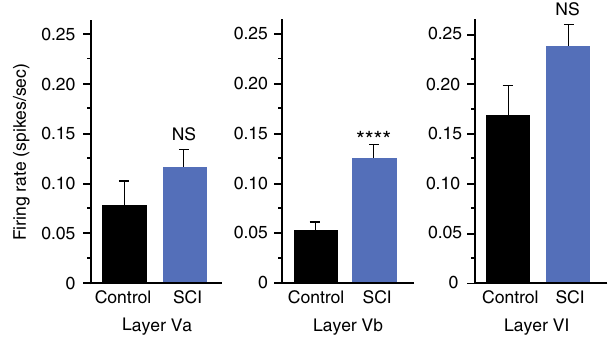
Fig. 4 Spontaneous single-unit fi ring rate in hindlimb cortex 4 – 18 weeks following spinal cord injury. Mean spontaneous fi ring rates of isolated single-units in layers Va, Vb, and VI of the hindlimb motor cortex in control rats ( n = 5) and rats with a spinal cord contusion at T9-10 ( n = 14). Laminar estimates are based on the depths of electrode sites on a single-shank multi-electrode array relative to the cortical surface 26 . In each rat, single-unit (spike) activity was sampled from 4 to 6 locations within neurophysiologically identi fi ed hindlimb motor cortex. Data represent the mean fi ring rates of 1744 isolated units in Layers Va (control, n = 124; SCI, n = 312), Vb (control, n = 155; SCI, n = 390), and VI (control, n = 217; SCI, n = 546). Two-tailed t-test, t = 3.99, **** p <